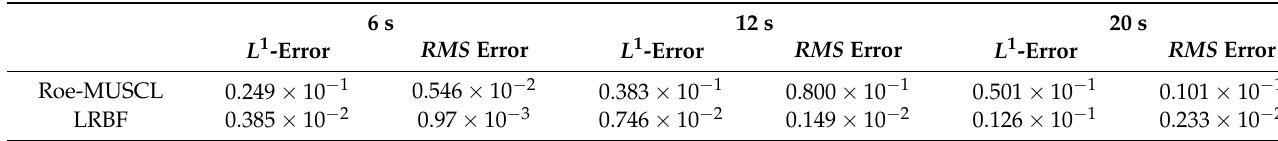
Table 1. Results for the accuracy of the pollutant advection example using the LRBF and finite volume methods.